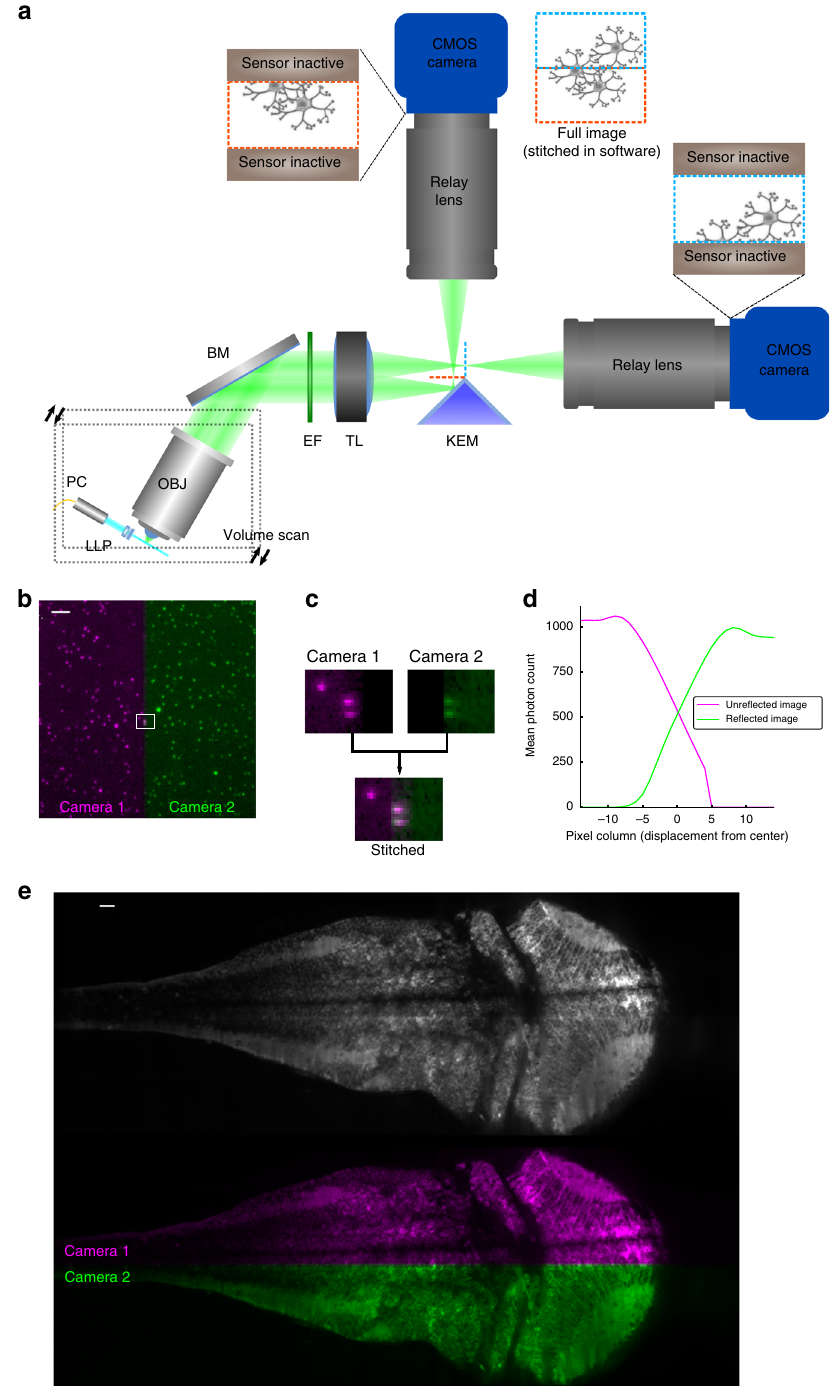
Fig. 3 Mitigating the camera bottleneck. a A two-camera shared-image OCPI system. A knife-edged prism mirror (KEM) takes the place of the camera sensor in Fig. 1b. The mirror is aligned so that half of the image is re fl ected and relayed to a camera above while half passes unimpeded and is relayed to a second camera. Cameras are aligned so that they image a centered horizontal band in the fi eld of view. The two cameras expose synchronously, and their images are later stitched together into a full image. Since the frame rate of a CMOS camera depends only on image height (Fig. 1e) this doubles the imaging speed of the system. b Example stitched image of fl uorescent beads (0.2 μ m diameter) with one camera ’ s image in magenta and the other in green. Scale bar: 20 μ m. c Zoomed view of the rectangular region marked in panel b showing a pair of beads in the narrow region imaged by both cameras, corresponding to the apex of the KEM. d Quanti fi cation of a stitched image of fl uorescene dye solution with the same width and location as shown in panel c . The width of the redundant image region is approximately 10 pixels (less than 0.3% of the camera chip width). e Pseudocolored and grayscale views of the same stitched slice of a larval (5 dpf, HuC:GCaMP6s ) zebra fi sh brain. Scale bar: 20 μ